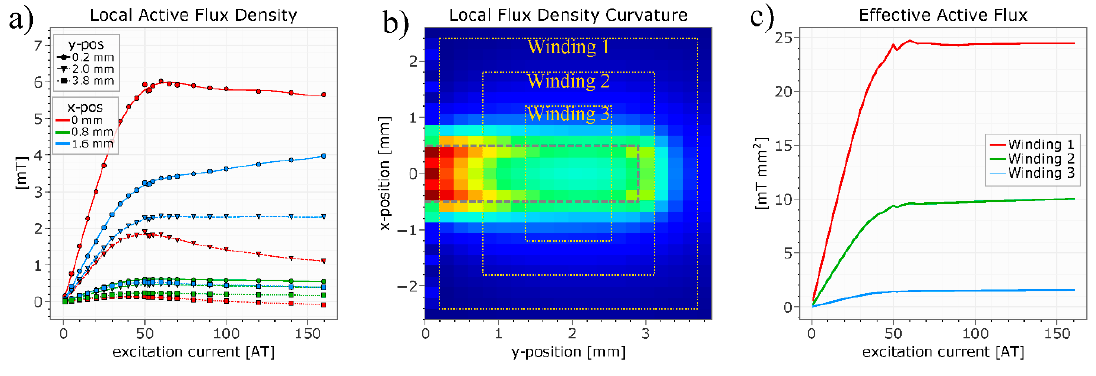
Figure 2. FEM simulation